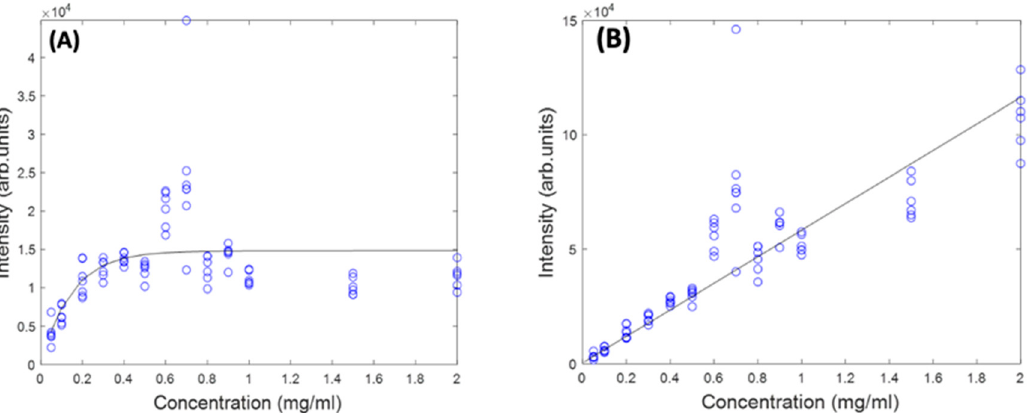
Figure 5. Concentration dependence of 1519 cm − 1 Raman peak of Beta Carotene at 532 nm before ( A ) and after ( B ) self-absorption correction. and after ( B ) self-absorption